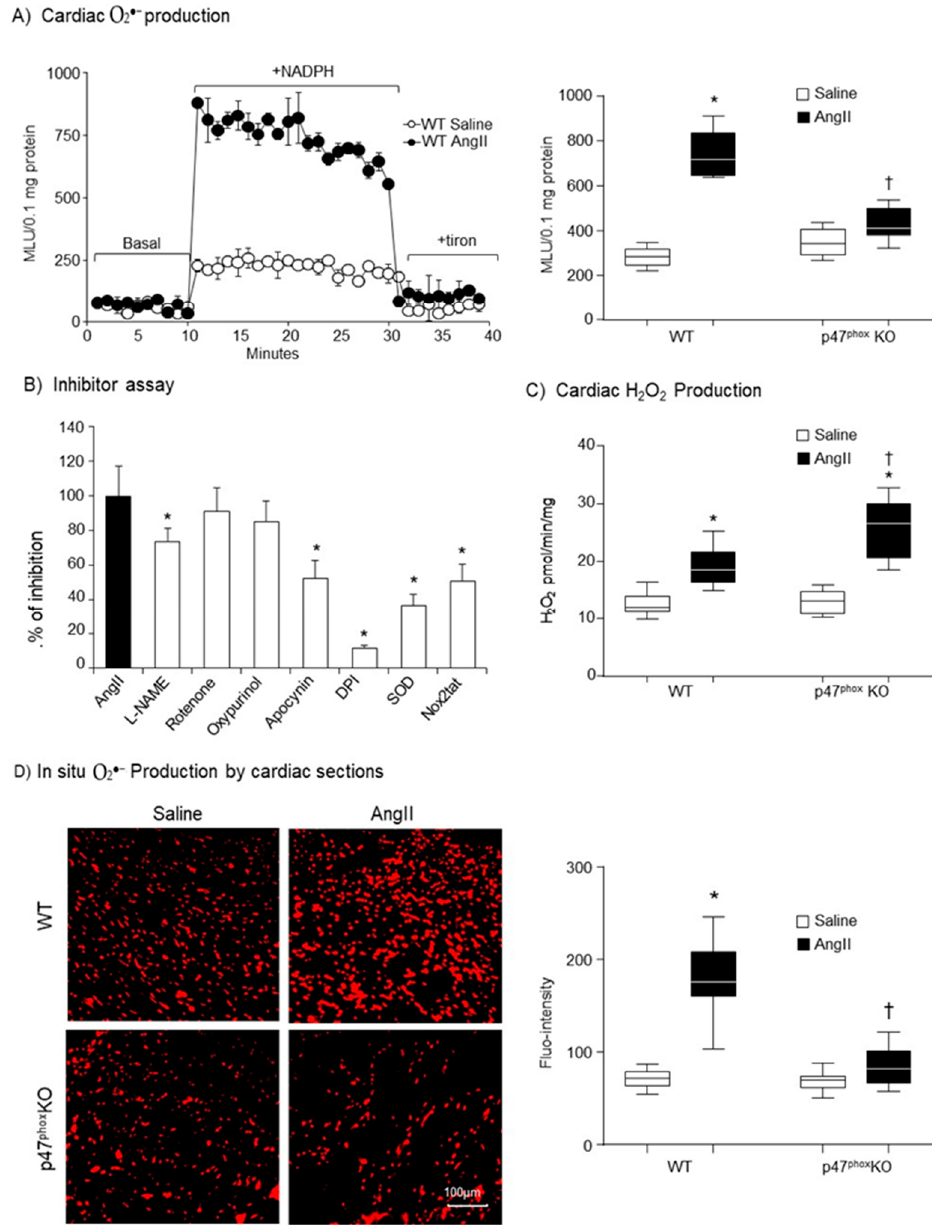
Figure 2. Cardiac ROS production. ( A ) Levels of O 2 ●− production measured by lucigenin ‐ chemiluminescence. Left panel: Representative examples of kinetic measurements of O 2 ●− production by WT heart homogenates. NADPH (0.1 mM) was added at 10 min. Tiron (10 mM) was added at 30 min to scavenge O 2 ●− . Right panel: Differences in NADPH ‐ dependent O 2 ●− production measured between 10–30 min shown in the left panel. ( B ) The effects of different enzyme inhibitors on the levels of O 2 ●− by AngII ‐ infused WT heart homogenates. L ‐ NAME: (NG ‐ nitroarginine methyl ester), NOS inhibitor; Rotenone: mitochondrial respiratory chain inhibitor; Oxypurinol, xanthine oxidase inhibitor; DPI: (diphenyleneiodonium), flavoprotein inhibitor; SOD: (superoxide dismutase). ( C ) Cardiac H 2 O 2 production detected by amplex red assay. ( D ) In situ detection of reactive oxygen species production by DHE fluorescence. Left panel: Representative images of DHE staining on cardiac sections; right panel: Quantification of DHE fluorescence intensity. n = 9 per group. Statistical comparisons were done using one ‐ way ANOVA for inhibitor assay, and two ‐ way ANOVA for the rests (panels A, C, D). * p < 0.05 for indicated AngII values versus saline values in the same genetic group; † p < 0.05 for p47 phox KO AngII values versus WT AngII values.